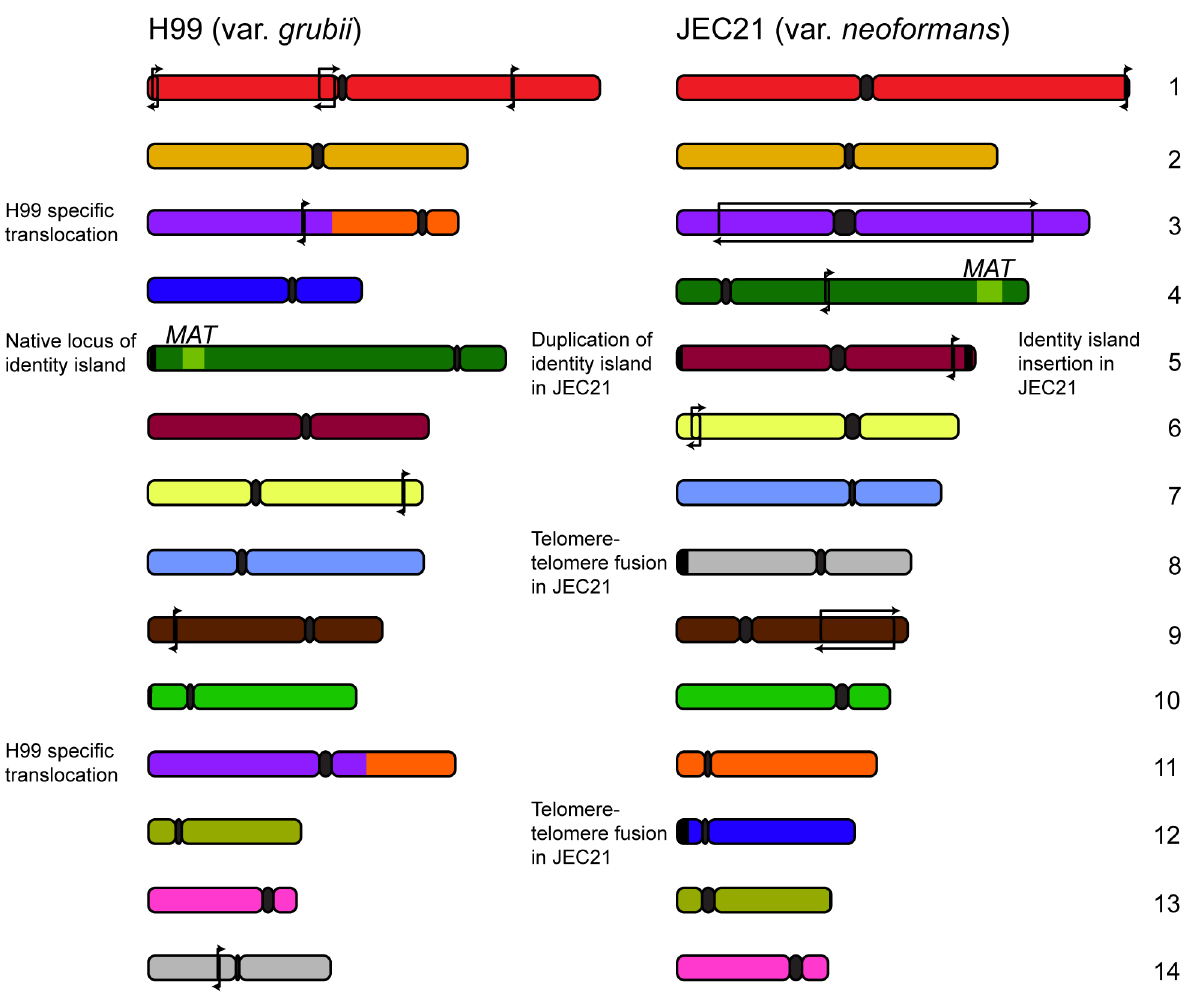
Figure 1. Genomic comparisons between var. grubii and var. neoformans reveal relatively few rearrangements. Since divergence 18.5 million years ago, the two varieties of C. neoformans have maintained a largely syntenic genome structure with only a few inversions specific to each variety (marked with arrows). Comparisons also uncovered several strain-specific events: a translocation in the case of the var. grubii type strain H99 and telomere-telomere fusion and introgression in the case of var. neoformans